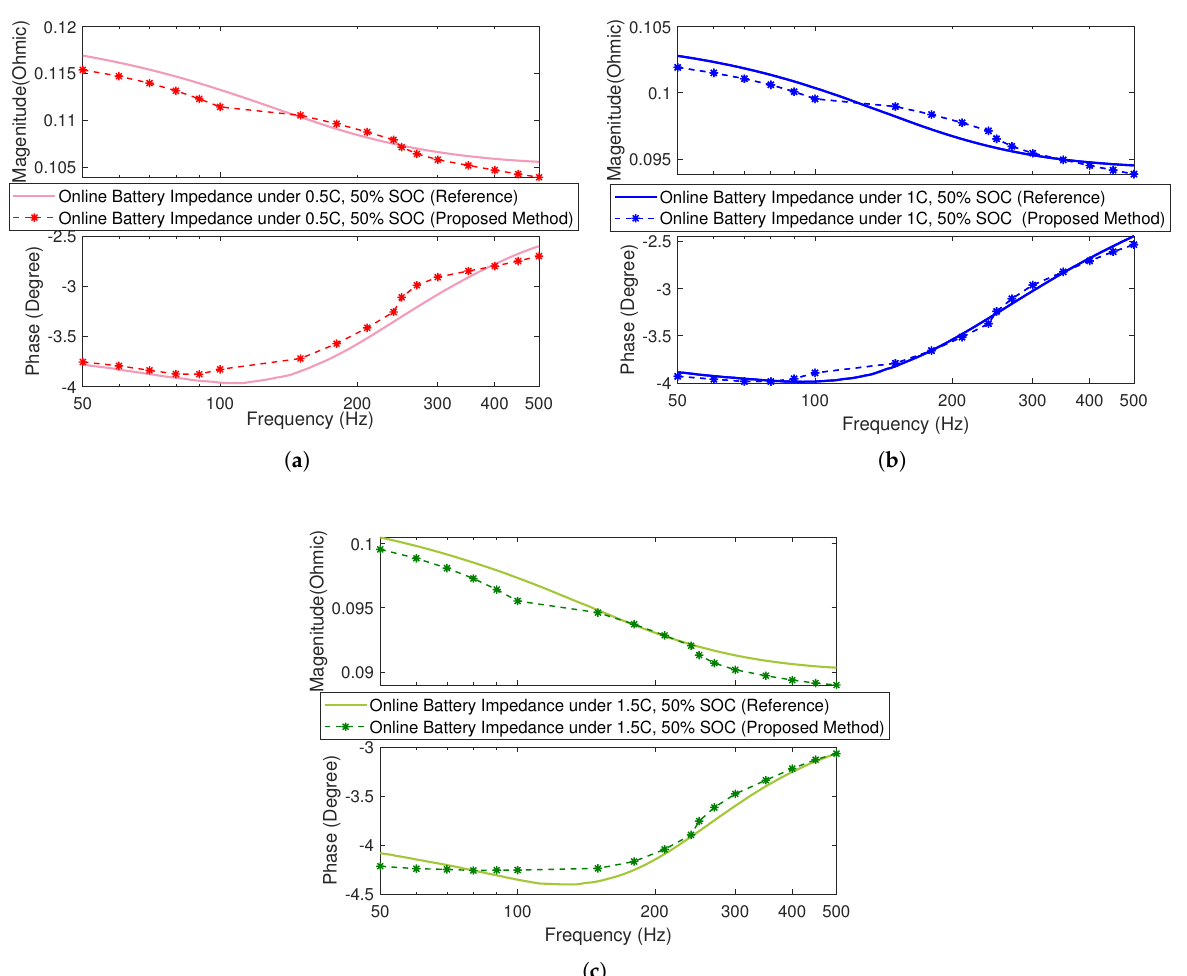
Figure 9. Online battery impedance results (50 Hz to 500 Hz) under different discharge current rates ( a ) under 0.5C, 50% SOC ( b ), under 1C, 50% SOC, and ( c ) under 1.5C, 50%